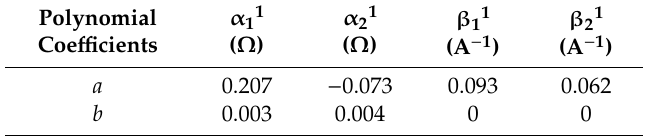
Table 11. Nonlinear parameters for MT2 pi-circuit as a function of soil resistivity.